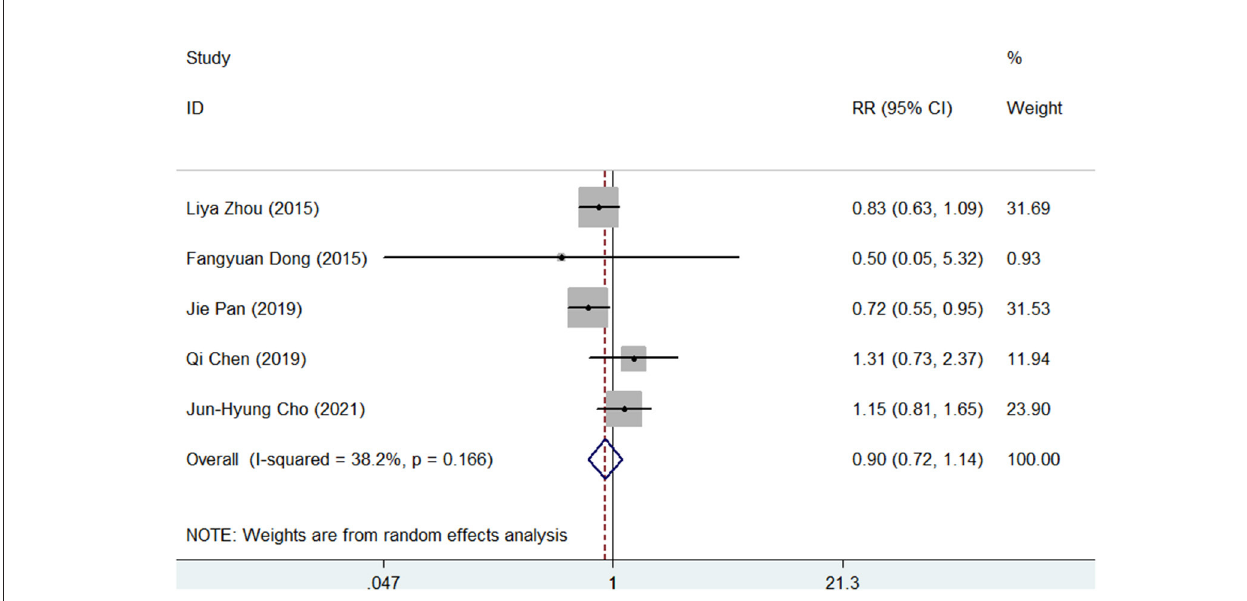
FIGURE 5 | Forest plots for the comparison of SGT vs. BQT in side effects.